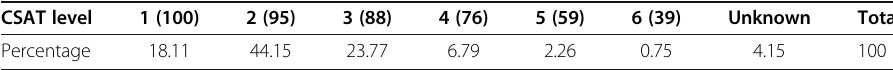
Table 1 CSAT English levels of Korean participants CSAT